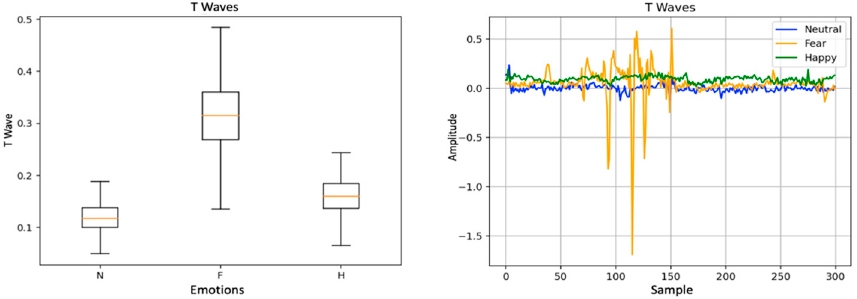
Figure 3. Representation of T Wave time series (at right), and the corresponding box plot (at